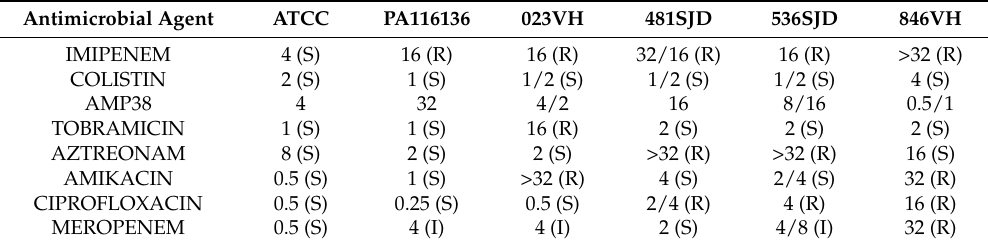
Table 1. Antimicrobial susceptibility (minimum inhibitory concentration, MIC) ( μ g/mL). R: resistant; S: susceptible.